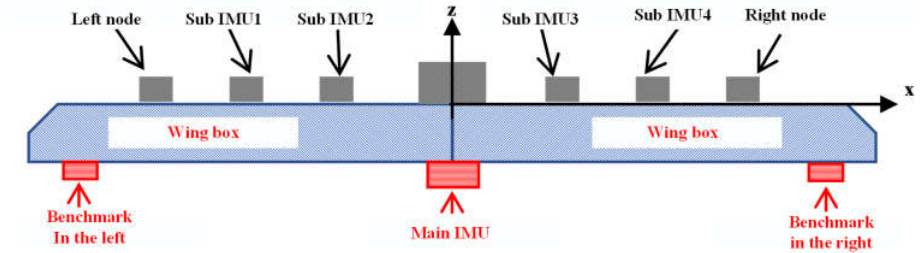
Figure 4. The whole flight experiment process.